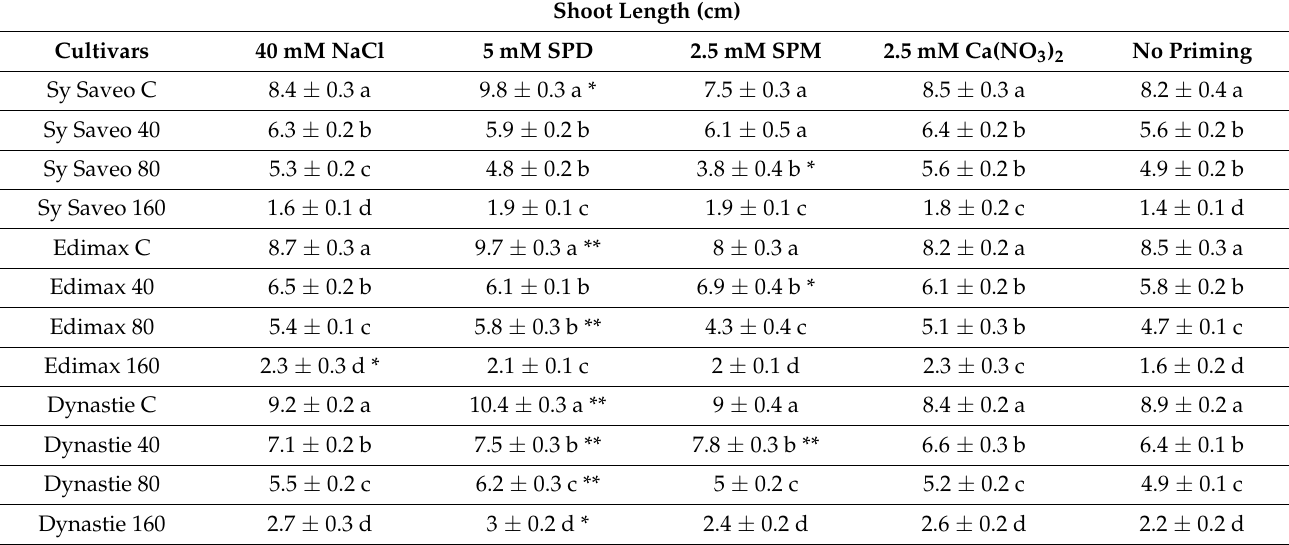
Table 2. Effect of different priming agents on shoot length (cm) of rapeseed cultivars exposed to different saline conditions: 0 mM NaCl (C), 40 mM NaCl (40), 80 mM NaCl (80), 160 mM NaCl (160). Data are expressed as means ± SE ( n = 8). Mean values in the column marked by different letters are significantly different within the same group ( p ≤ 0.05; ANOVA and Tukey–Kramer test). Significant differences between groups are reported as * p < 0.05; ** p < 0.01; *** p <